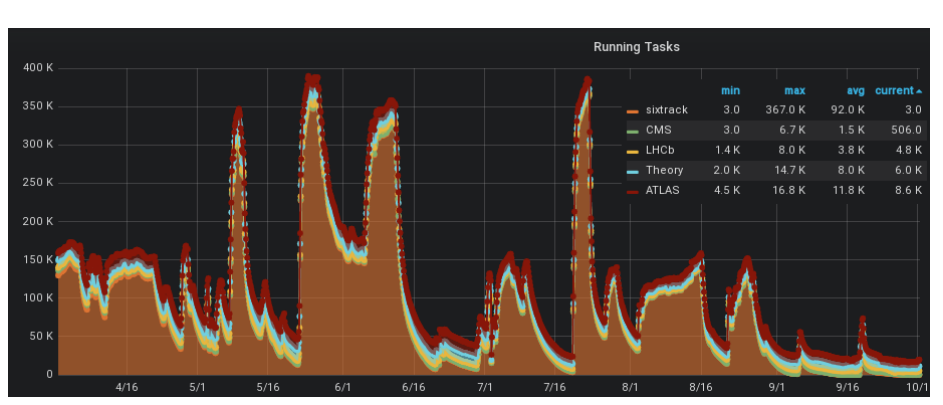
capacity contributed from volunteers compares with that of a Tier-2 WLCG site for the ex- periment applications. For Sixtrack, the number of active volunteers is much higher, as there is no need for virtualisation to run the Sixtrack executables. During simulation campaigns, a total of more than 80 TFLOPS of contributed computing power has been made available by volunteers. (Ref. fig. 2.) Hence the contributed computing power for Sixtrack is far more